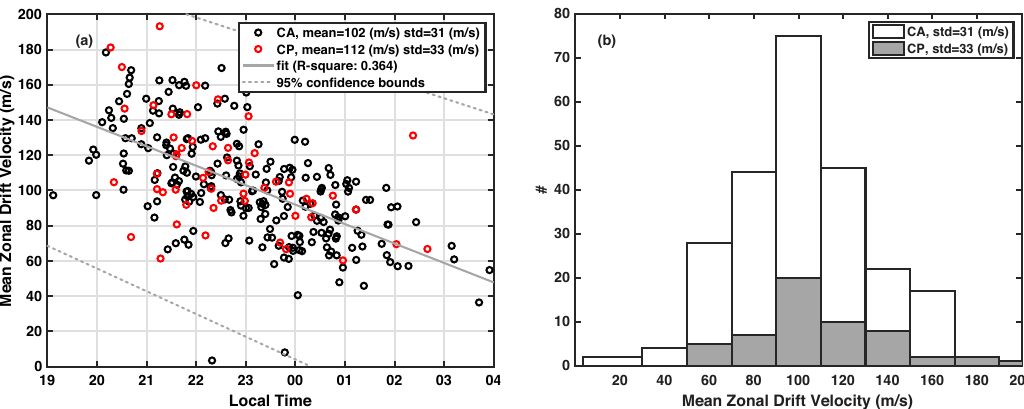
Figure 2. ( a ) Mean zonal drift velocities of EPBs in Cariri (black) and Cachoeira Paulista (red) as functions of the local time. A linear fit (gray line) depicts that smaller velocities occur in later hours of the observation period. ( b ) Histogram of mean zonal drift velocity distributions for Cariri (white blocks) and Cachoeira (gray